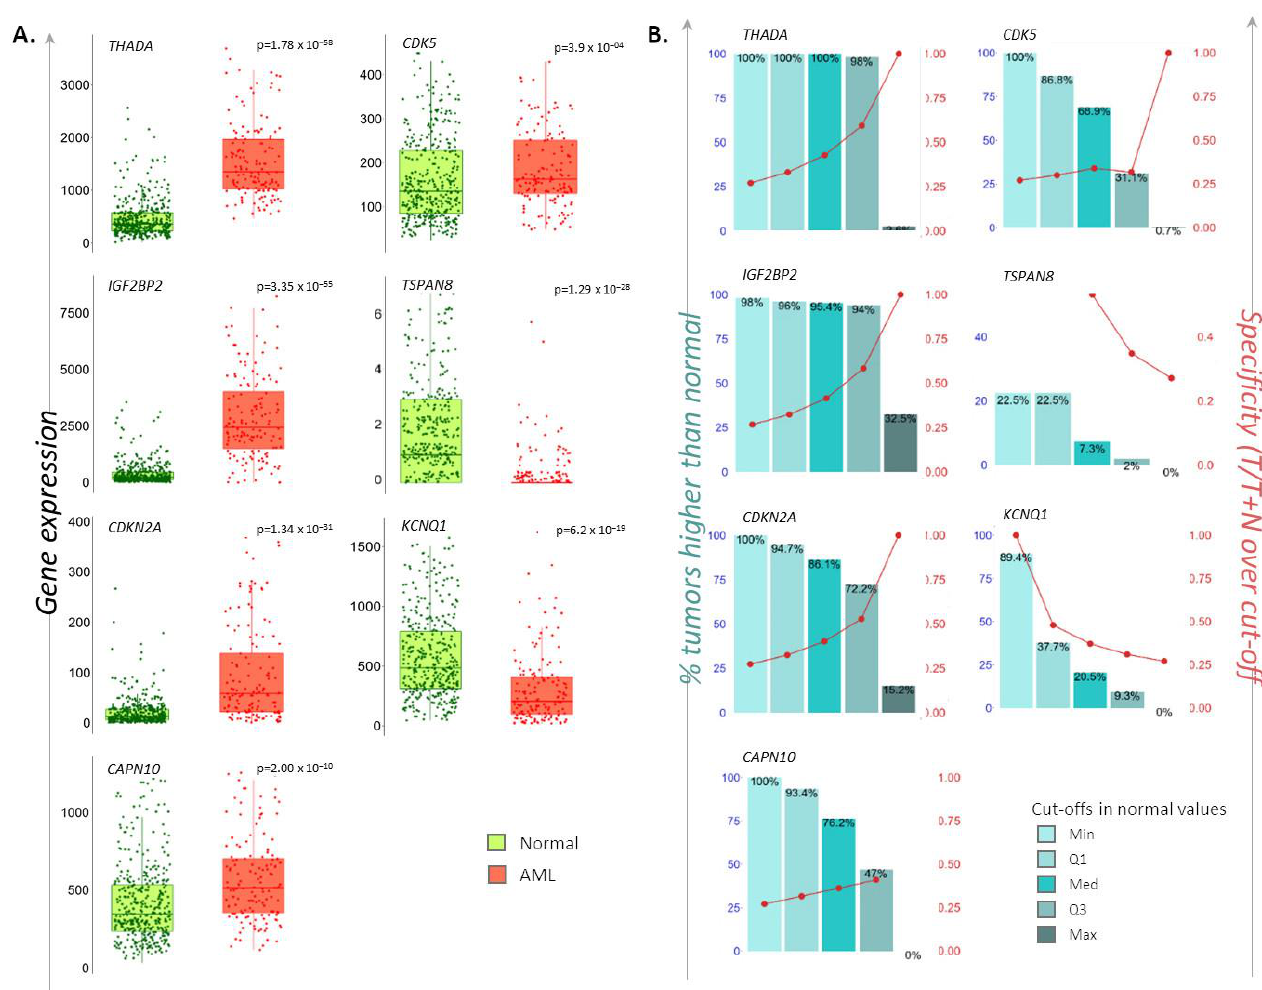
Figure 5. Differential expression levels of T2D-related genes in AML individuals. ( A ). Dot-plot/whisker bars depicting the differential mRNA levels of the CAPN10 , CDK5 , CDKN2A , IGF2BP2 , KCNQ1 , THADA , TSPAN8 T2D susceptibility genes in AML patients. P -values of significance as obtained by Mann – Whitney test are reported. ( B ). Bar diagrams showing the: (i) percentage (%) of AML samples that possesses higher or lower of each gene-of-interest compared to non-cancerous samples, at each of the four quantile cut-off values (minimum, 1st quartile, median, 3rd quartile, maximum) (left y-axis), and (ii) specificity defined as the ratio of the number of AML samples to the sum of AML and non-cancerous samples over or below each given cut-off (right y-axis).